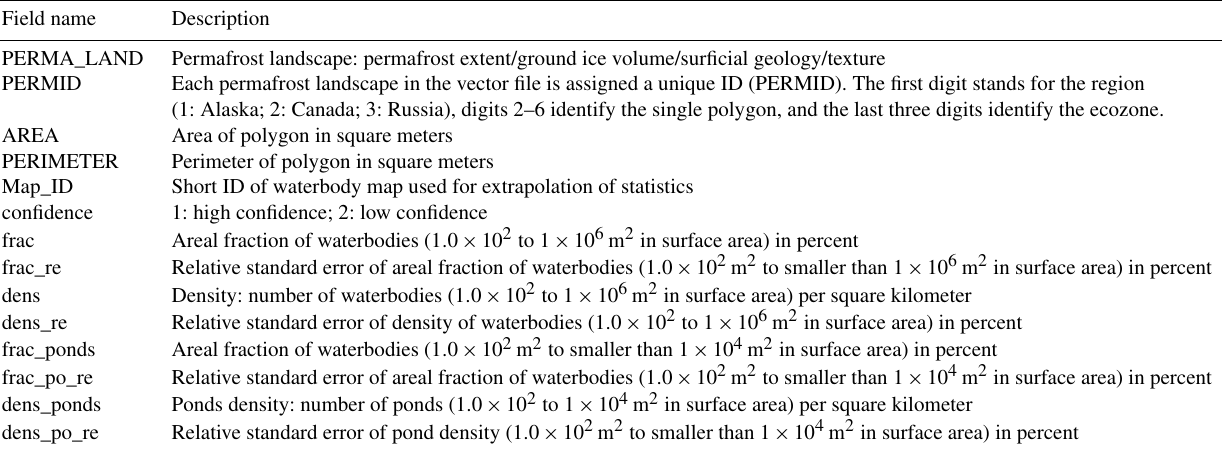
Table 3. Attributes of ESRI shape file PeRL_perma_land.shp.